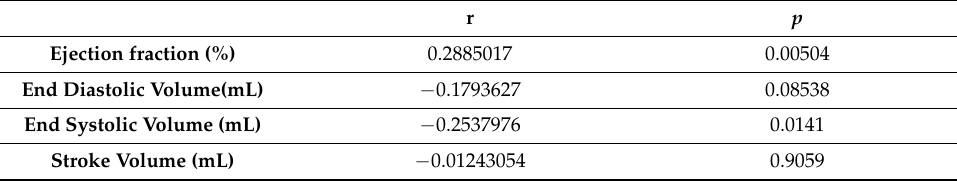
Table 2. Correlation between EAD and Cardiac Function parameters. Person test results (r) and p values are also